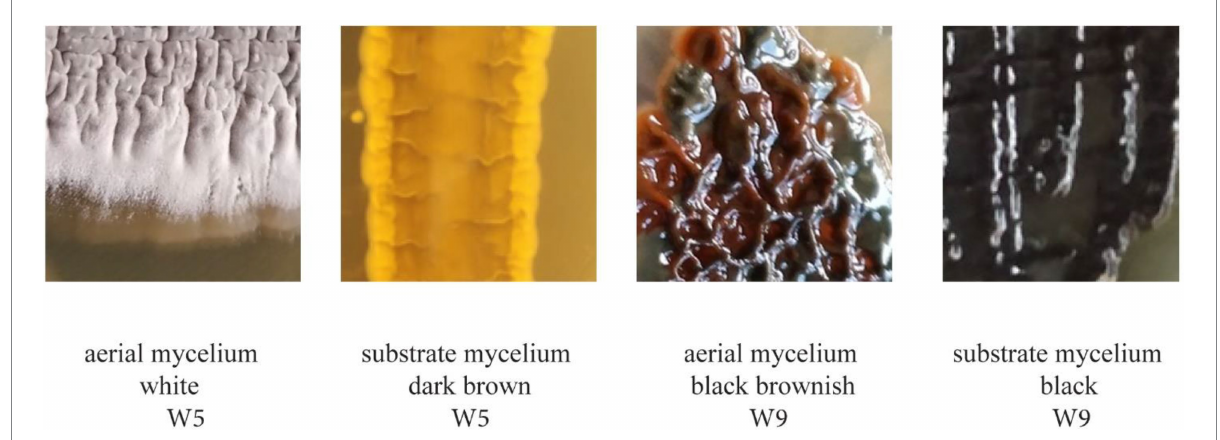
FIGURE 3 Difference in color between the aerial mycelium and the substrate mycelium of strains W5 and